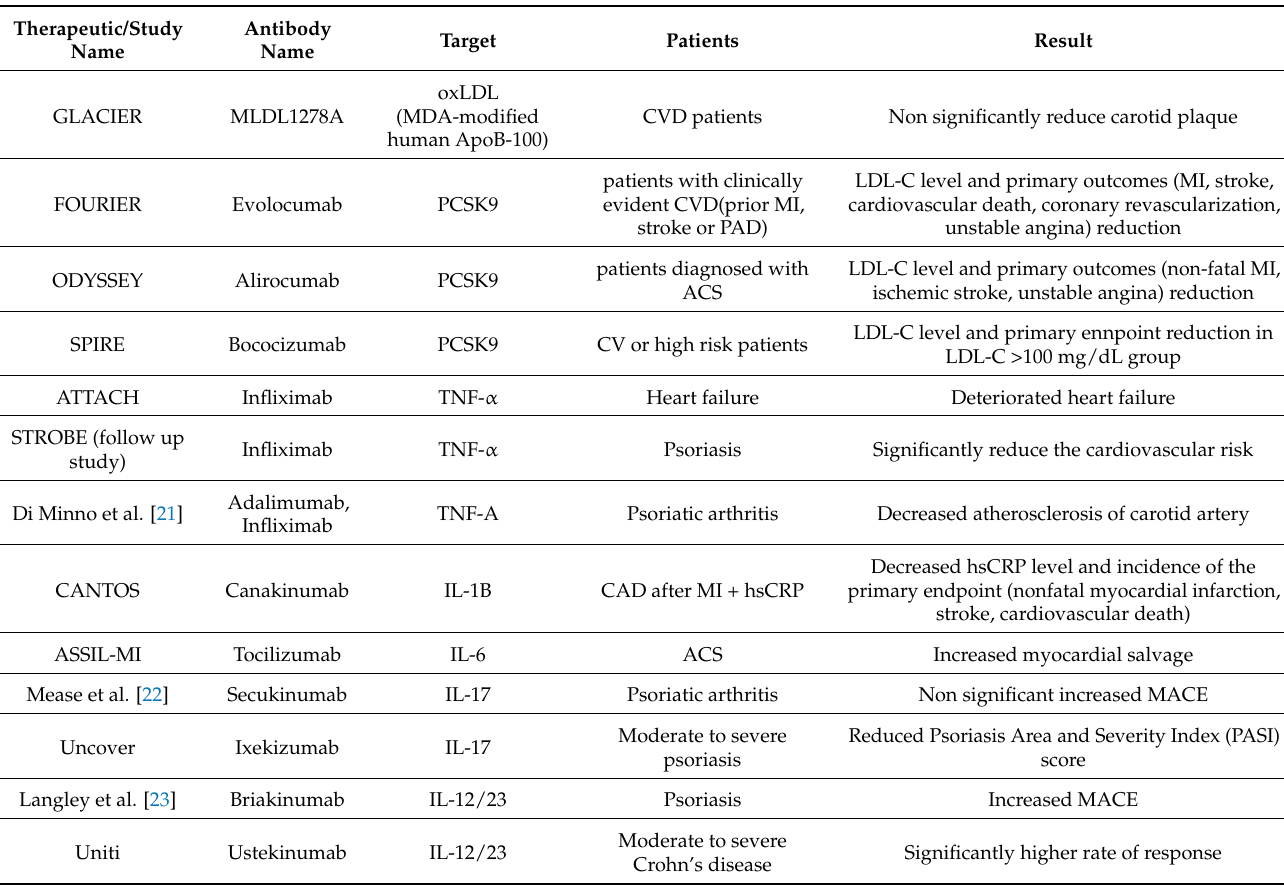
Table 1. Summary of antibody based clinical